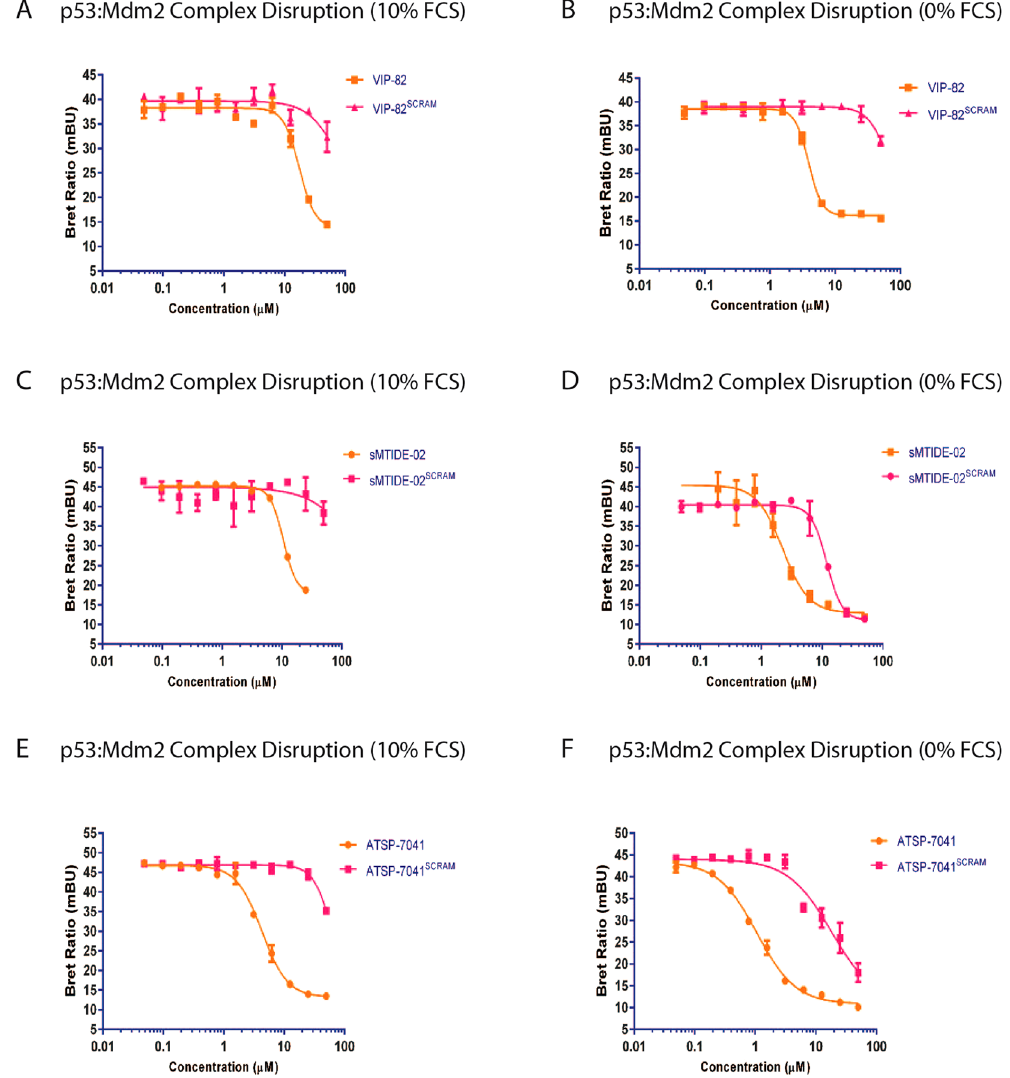
Figure 3. Disruption of intracellular Mdm2:p53 complexes were assessed using the nanoBRET assay (Promega) and IC50s were determined. Titrations were carried out in pairs between the active stapled peptide and the scrambled control variant to determine the window of specificity between targeted disruption of the Mdm2:p53 complex and the onset of non-specific cellular effects: VIP-82 and VIP-82 SCRAM ( A ) in 10% FCS and ( B ) 0% FCS, sMTIDE-02 and sMTIDE-02 SCRAM ( C ) in 10% FCS and ( D ) 0% FCS, and ATSP-7041 and ATSP-7041 SCRAM in ( E ) 10% FCS and ( F ) 0% FCS. Titrations were performed on HEK293 cells and nanoBRET signal was measured after 4 hours.